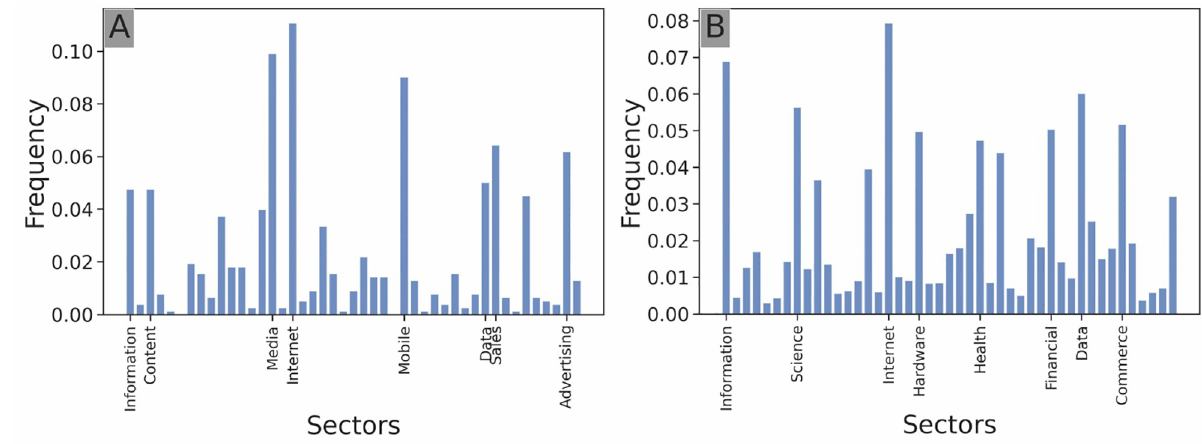
Fig 4. Sectoral investment distribution. Sectoral investment distribution of Softbank Capital ( A ) and Y Combinator ( B ). Only the top 8 sectors of investment are labeled. Softbank Capital shows a strong focus on IT-related ventures whereas Y Combinator shows a wider sectoral breadth.